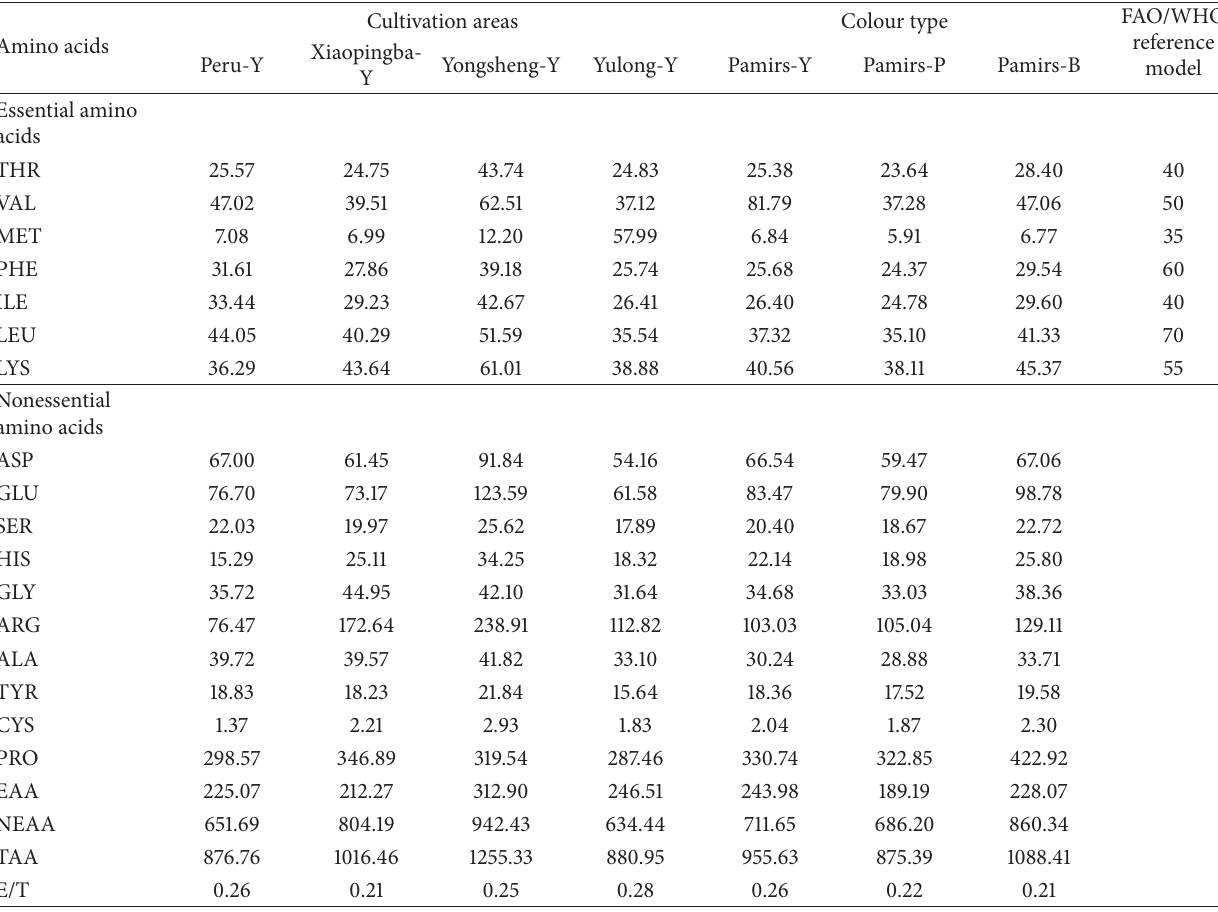
Table 3: Amino acid composition (mg/g protein) in maca samples of different cultivation areas and colour types. Cultivation areas Colour type Amino acids Essential amino